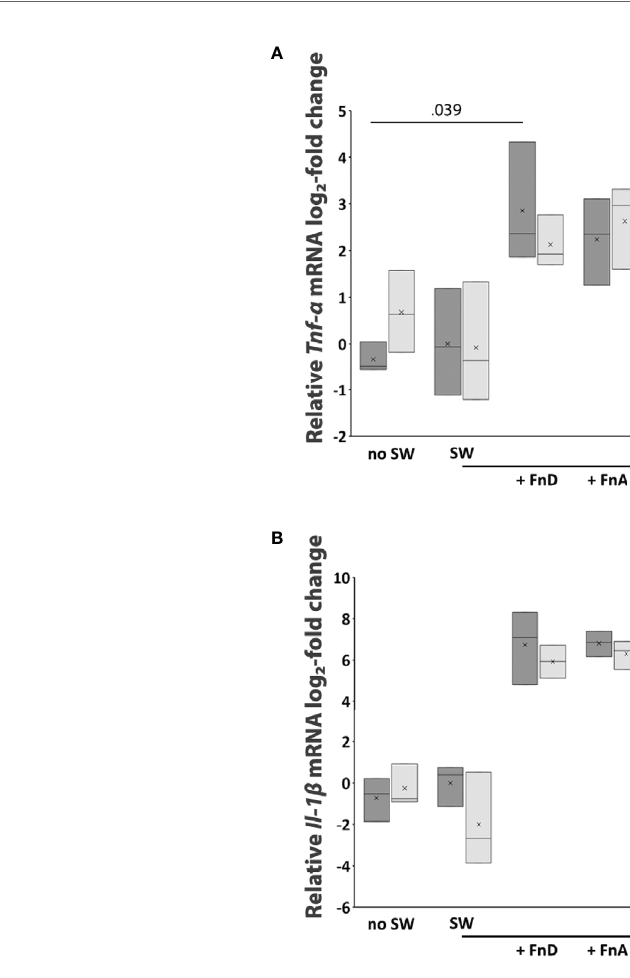
FIGURE 4 | Pro-in fl ammatory cytokines TNF- a and IL-1 b are upregulated by FnD, FnA, Fn6-8, and EGFL fragments in astrocyte cultures of both genotypes. (A) Relative log 2 -fold change of Tnf- a mRNA expression 6 h after scratching and fragment addition is presented in a box-and-whisker plot. Two-way ANOVA shows that only the treatment effect was signi fi cantly different ( p < 0.001). In both TnC+/+ and TnC-/- genotypes, FnD, FnA, Fn6-8, and EGFL upregulate Tnf- a mRNA levels (~ 2 log 2 -fold change for all conditions) versus the no SW, SW, and FnC groups. Only the FnD fragment statistically upregulates Tnf- a mRNA levels versus the no SW in TnC+/+ cultures ( p = 0.039). n = 3 independent astrocyte culture preparation. (B) Relative log 2 -fold change of Il-1 b mRNA levels 6 h after scratching and fragment addition as presented in the box-and-whisker plot. Two-way ANOVA shows that only the treatment was statistically signi fi cant ( p < 0.001). In TnC+/+ and TnC-/- cultures, addition of EGFL, FnA, FnD, and Fn6-8 upregulates Il-1 b mRNA levels (~ 7 log 2 -fold change, p ≤ 0.001 for all conditions) versus levels of no SW, SW, and FnC. n = 3 independent astrocyte